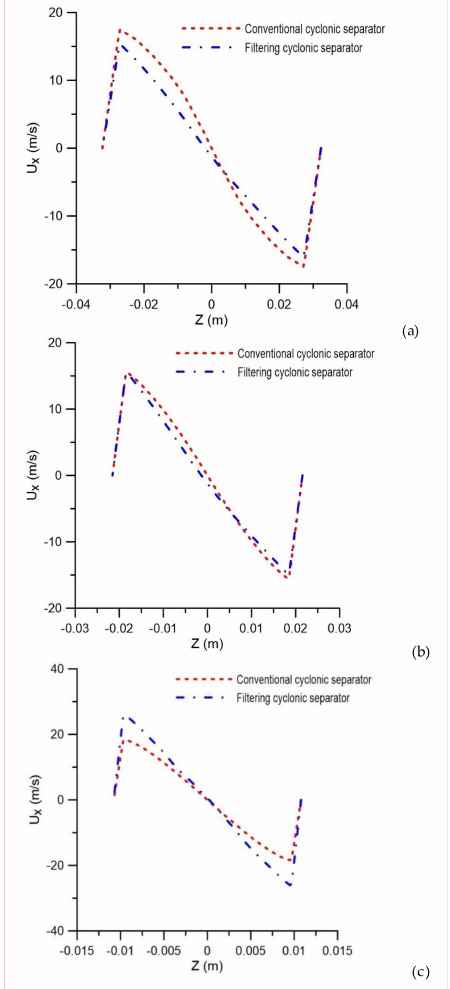
Figure 8. Tangential velocity profile in conventional and filtering hydrocyclones at the positions ( a ) y = 0.15 m, ( b ) y = 0.45 m and ( c ) y = 0.75